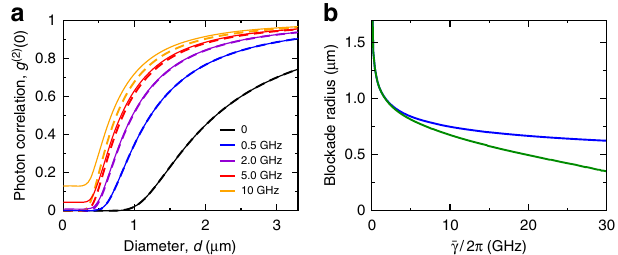
Fig. 3 Photon correlations. a Equal-time photon-photon correlations g (2) (0) of the transmitted light as a function of the diameter, d , of the illumination area for different Rydberg state linewidths, γ = 2 π , and resonant excitation of the 10 p -exciton at K + . b Critical photon-blockade radius R ð ph Þ for which g (2) b (0) crosses 0.5 (green) as a function of γ at fi xed Ω 2 Γ j j ¼ 40 GHz. The blue line shows the corresponding size R ð X Þ at which the probability to excite two b Rydberg excitons within the illumination area is suppressed by a factor of 2.